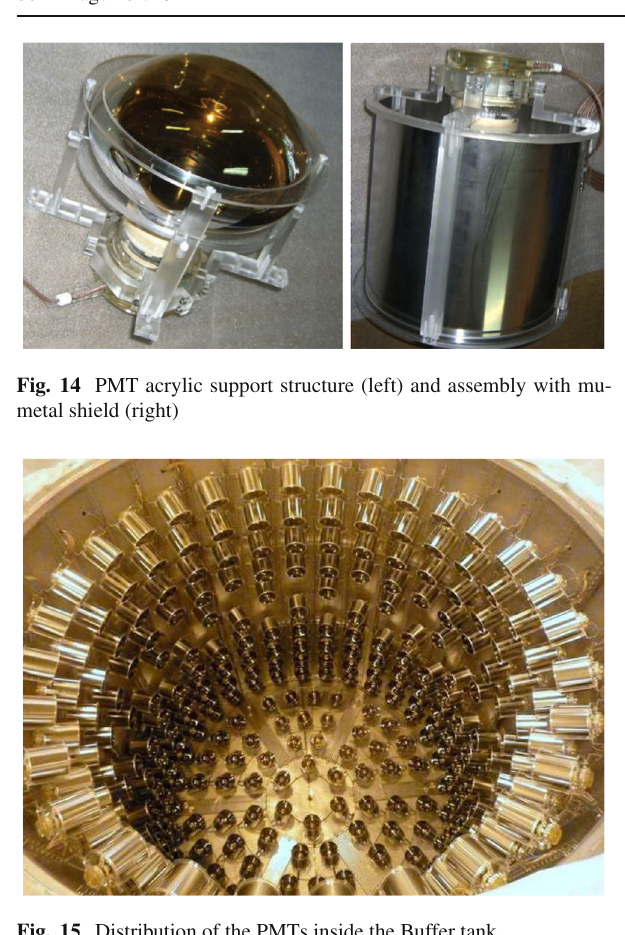
Fig. 15 Distribution of the PMTs inside the Buffer tank